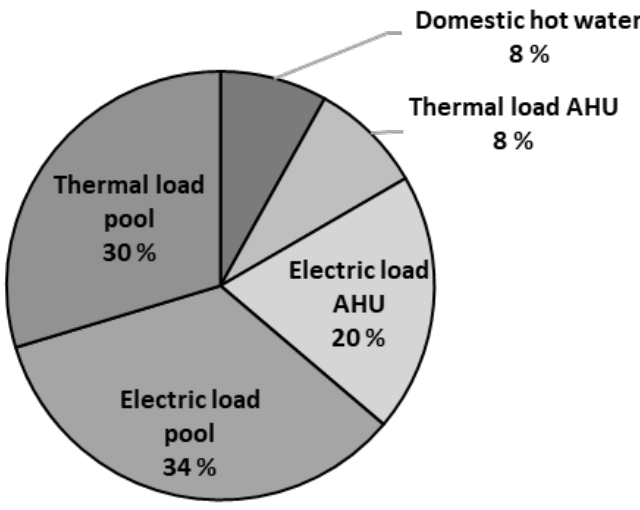
Figure 5. Energy distribution for the swimming facility incl. the energy use for domestic hot water heating.